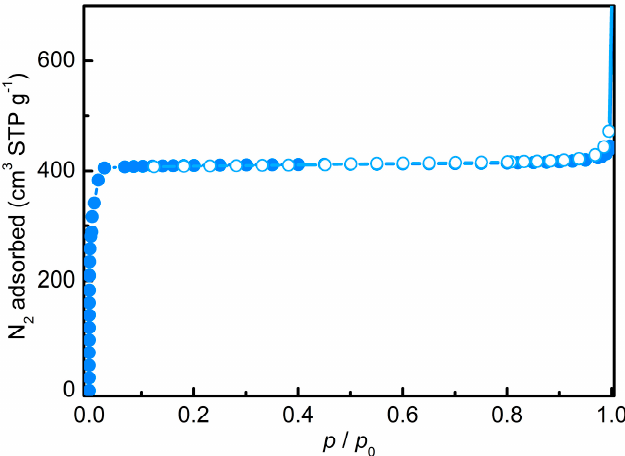
Figure A2. N 2 sorption measurements at 77 K on ZIF-8. Full and empty scatters refer to adsorption and desorption branches, respectively.